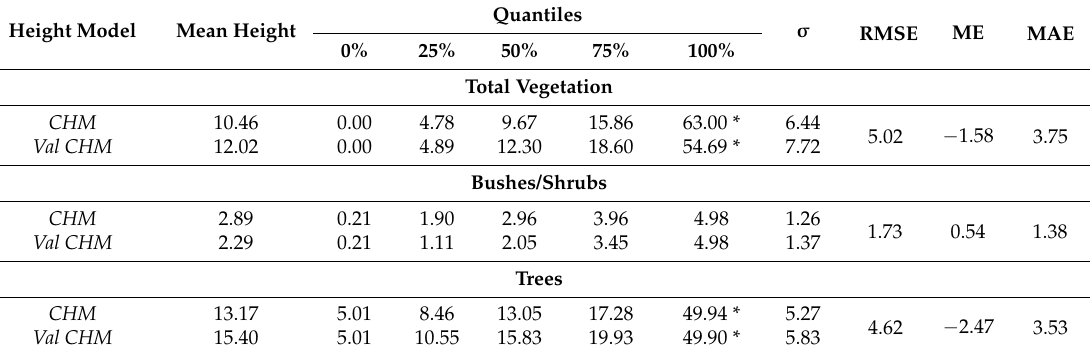
Table 2. Comparative statistics for all produced CHM and Validation CHM (Val CHM), measured in meters.